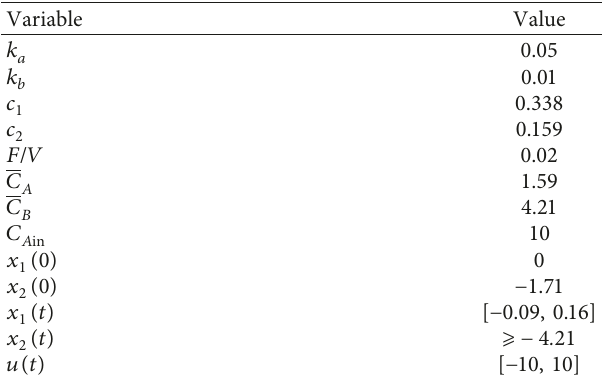
Figure 3: Control inputs using initial admissible controller and approximated optimal Table 1: Model parameters, initial conditions, and constraints.